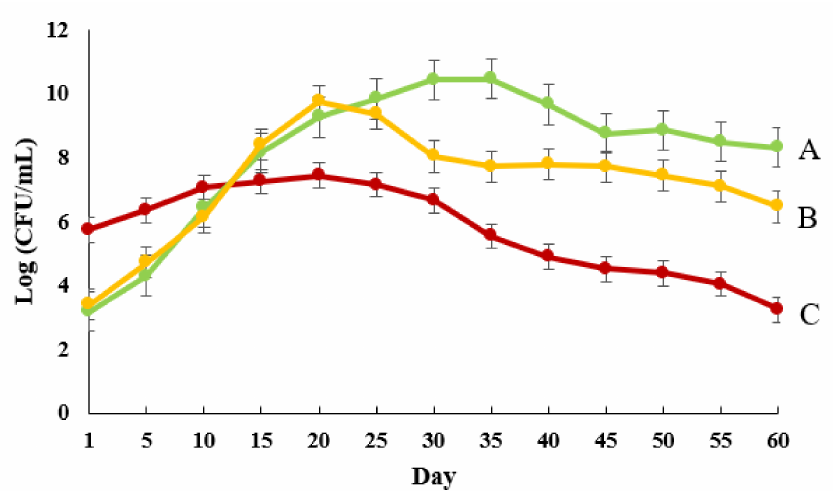
Figure 3. Release behavior of Pseudomonas chlororaphis VUPF506 encapsulated in ALG–WP–CNT microcapsules using different techniques. Error bars represent standard error (n = 3). ( A : Extrusion; B : emulsion; C : spray